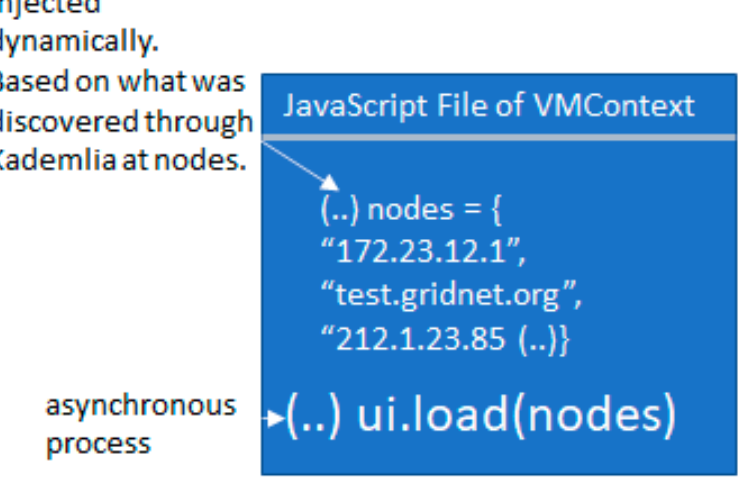
Figure 5 . Discovered peers injected into JavaScript files.